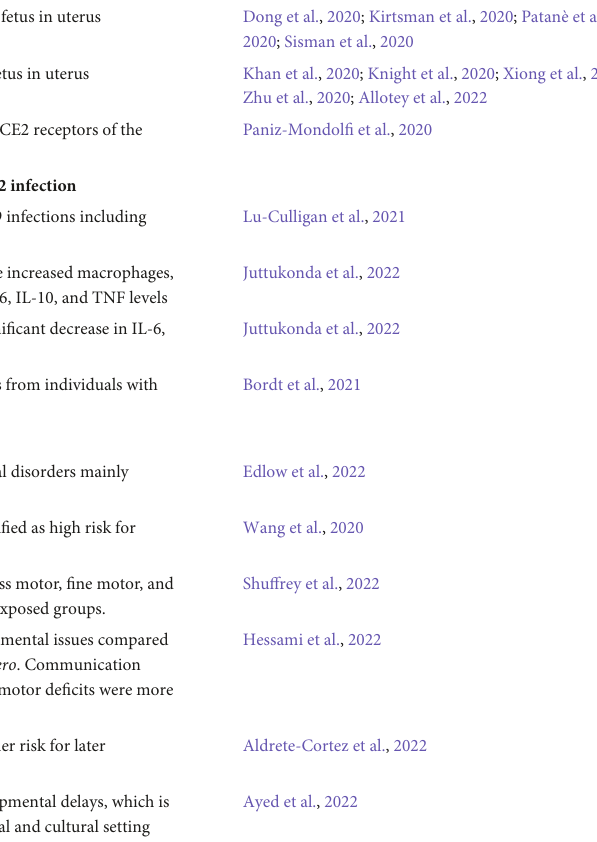
Transmission of SARS-CoV-2 mother to fetus SARS-CoV-2 virus infects fetus from direct transmission from infected mother to fetus in